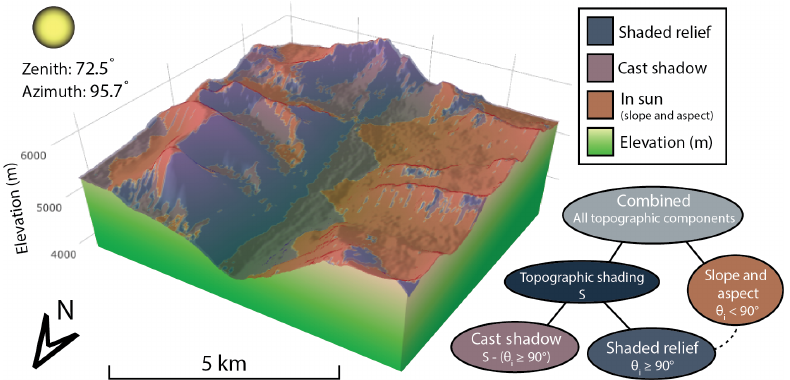
Figure 1. Comparing two different shading methods in the Satluj subbasin within the Indus watershed. Shading is calculated for 1 April 2013 at 07:33GMT + 6. Notice the importance of incorporating both methods in order to determine shading in this glacial valley. Both methods, but specifically cast shadows, are most prevalent early in the morning and late in the evenings when the zenith angle is large. Red coloring indicates areas “in sun” that are impacted by a change in irradiance due to the slope and aspect of the surface. Cast shadow, shaded relief, and “slope and aspect” are the three topographic components compared in this paper. Symbols in the flow chart relate to equations in Sect. 2; θ i denotes the incidence